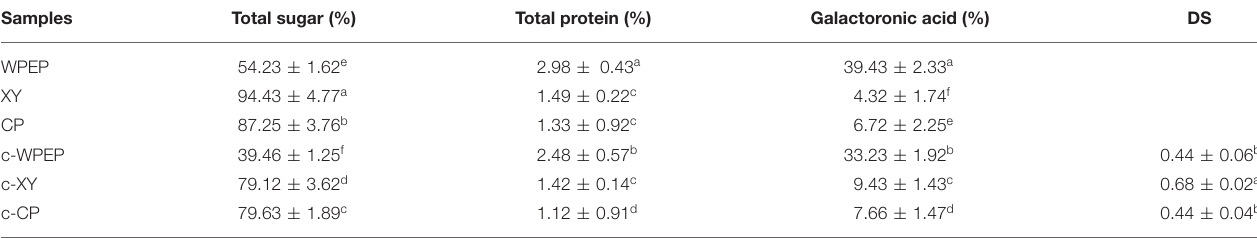
TABLE 1 | Chemical compositions of polysaccharide samples. Samples